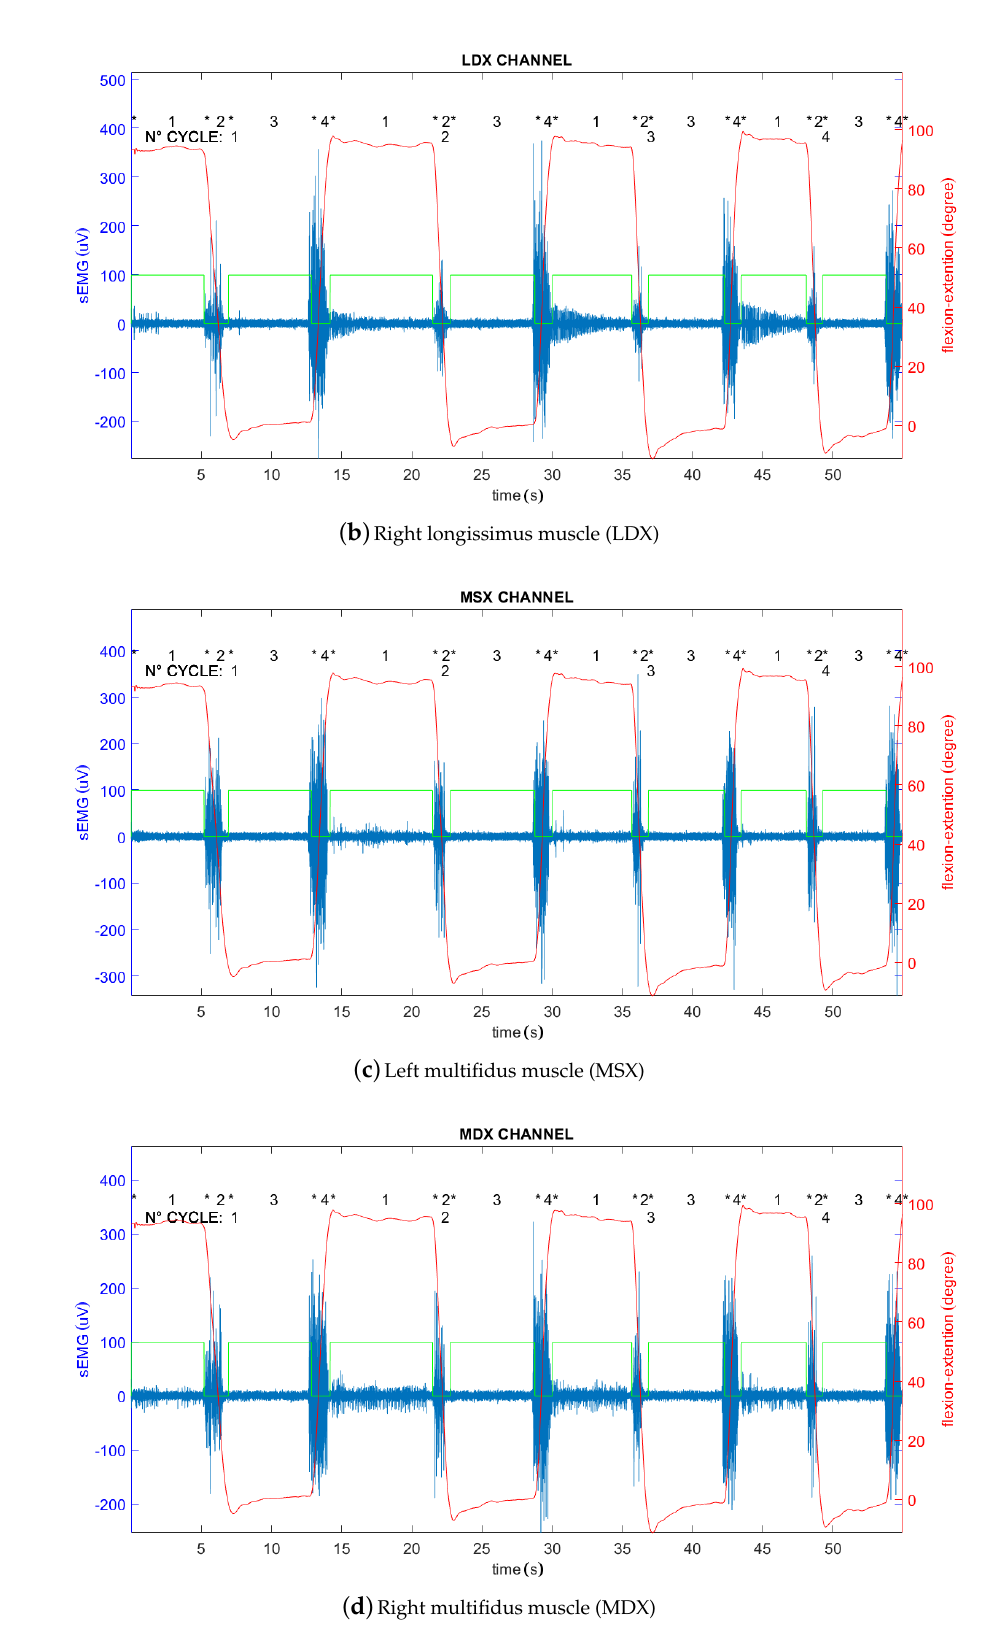
Figure 5. Graphic representation with the signals superimposition (filtered sEMG signal in blue, inclination signal in red, phases signal in green), phases (upper numbers: 1 standing, 2 flexion, 3 full-flexion, 4 extension), and cycles (lower numbers). This refers to a healthy subject (ID